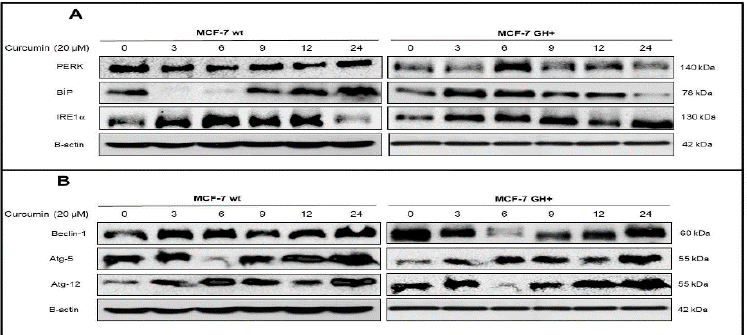
Figure 1. Curcumin triggers autophagy and ER stress in a time-dependent